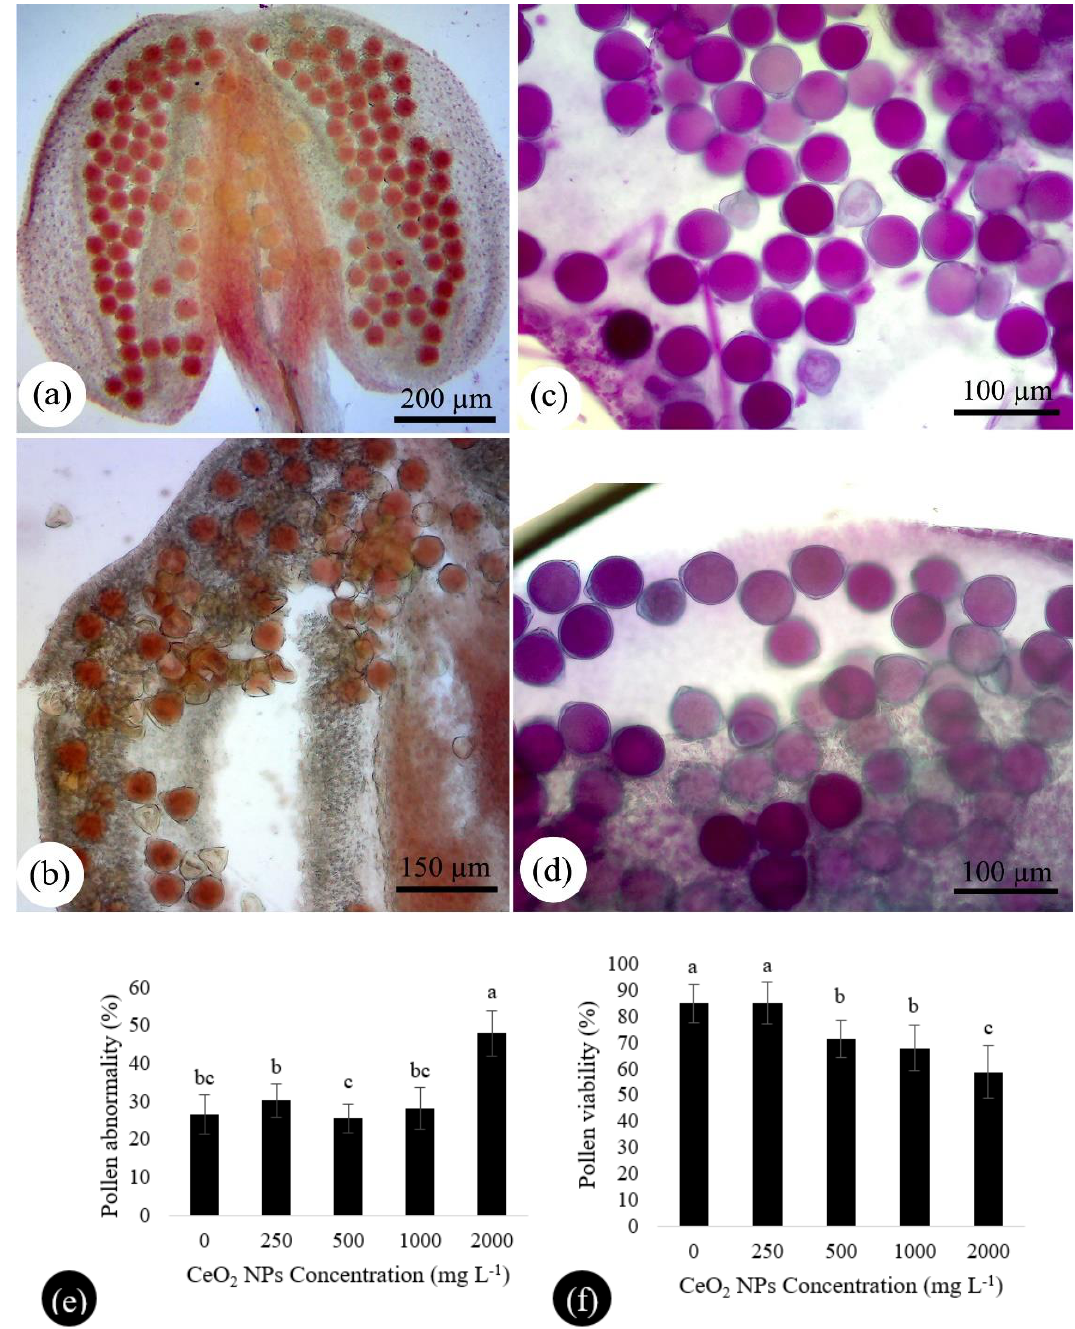
Figure 3. Acetocarmine ( a , b ) and Alexander ( c , d ) staining of pollens taken from mature anthers in control ( a , c ) and 2000 mg L − 1 nCeO 2 treatment ( b , d ). The anthers of control plants indicate higher viability by showing more colorful and complete filling pollens. In contrast, incomplete filing pollens with crumpled shapes indicate less viability. Pollen abnormality and pollen viability at different concentrations compared to control are represented in ( e ) and ( f ), respectively.